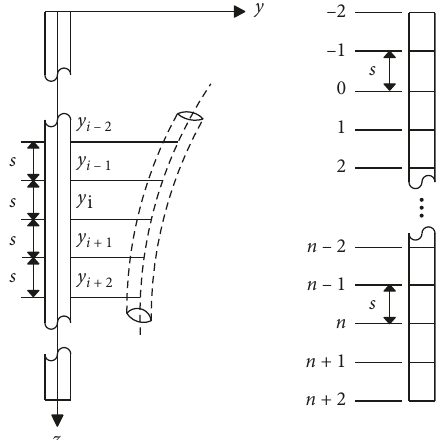
Figure 3: Simplified calculation model of near-slope